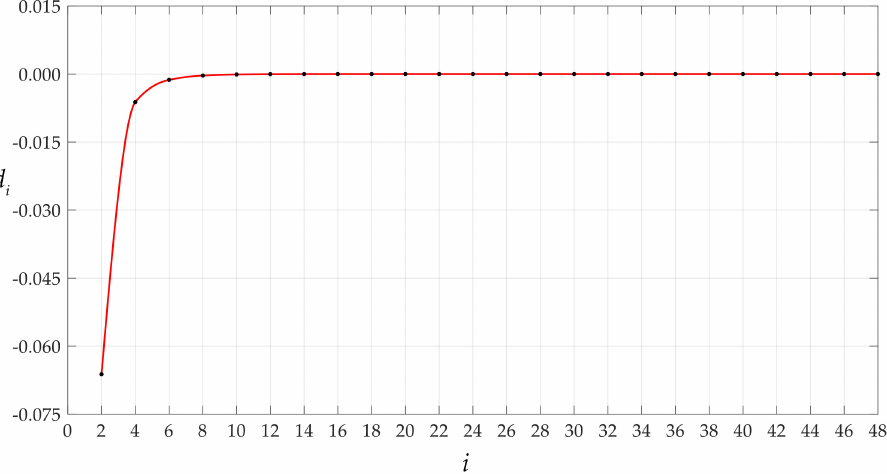
Figure 14. Variations of d i with i when q takes 0.0105 MPa.